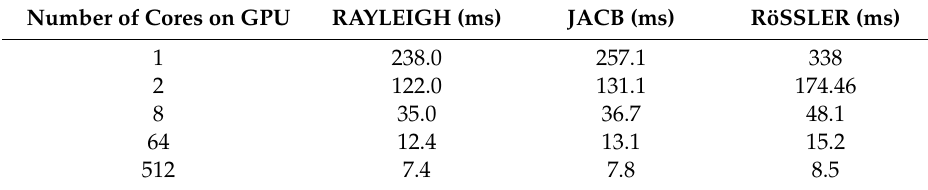
Table 2. The execution time of PAMCL for di ff erent selected di ff erential equations. The increase in number of cores does result in a decrease of the respective processing time. But by increasing the number of cores, this does result in more communication overhead amongst the